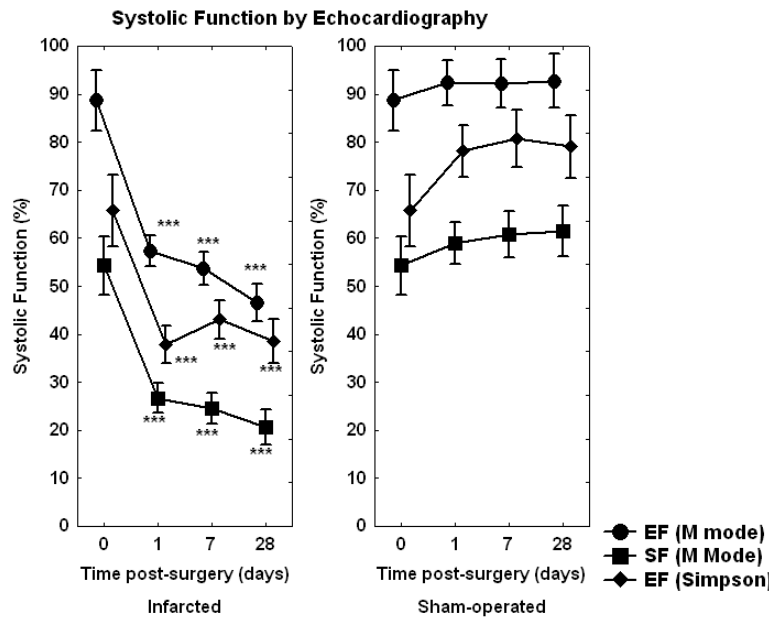
Fig. 1–Timecourseofsystolicfunctionininfarctedandsham-operatedrats. Allinfarcted rats have systolic function decreased independently from the measurement method